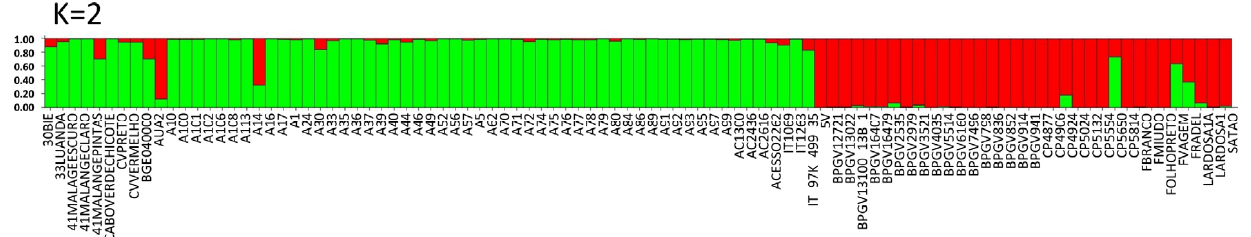
Figure 5. Population STRUCTURE of 97 cowpea accessions using SSR marker data as estimated using the model-based Bayesian algorithm implemented in the STRUCTURE program. Proportion of assignment of individuals to K = 2 subpopulation groups. Each accession is represented by a vertical line. Vertical lines with only one color (higher than 80%) were considered pure accessions. two axes, 21.01% in the first component and 7.75% in the second component. The Por- tuguese landraces are on the left side of the graph, while the accessions from Mozambique are on the right side of the graph. The Portuguese landraces CP5650, Lardosa 1A, F. vagem and the commercial variety Fradel did not group with the remaining Portuguese samples.